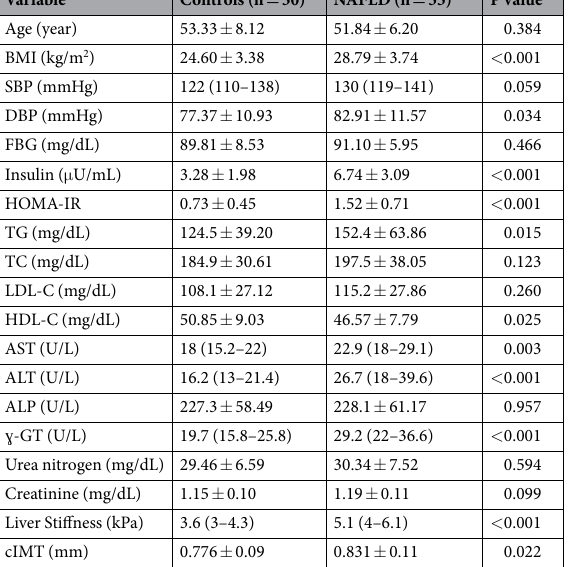
Table 1. Anthropometric and metabolic profiles of study population. Data are shown in mean ± SD for normal distributed variables and median (inter quartile range) for non-normal distributed variables. BMI, Body Mass Index; SBP, Systolic Blood Pressure; DBP, Diastolic Blood Pressure; FBG, Fasting Blood Glucose; TG, Triglyceride; TC, Total Cholesterol; LDL-C, Low Density Lipoprotein-Cholesterol; HDL-C, High Density Lipoprotein; AST, Aspartate amino Transferase, ALT, Alanine amino Transferase; ALP, Alkaline Phosphatase; ɣ -GT, Gamma-Glutamyl transferase; cIMT; carotid Intima Media